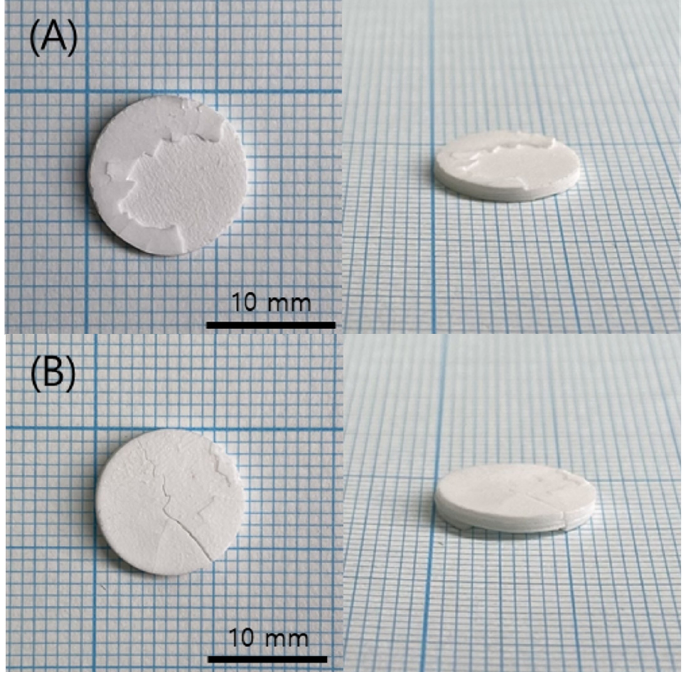
Figure 15. Sintered specimens according to various curing times: ( A ) 0.8s; ( B ) 1s.